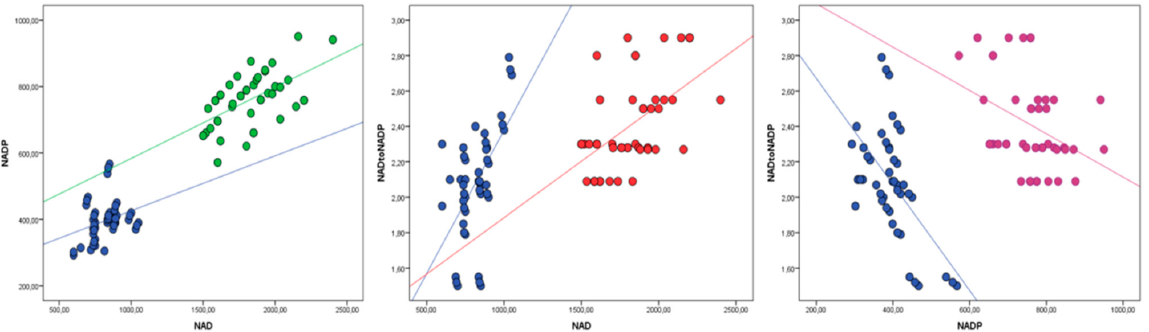
Figure 2. Linear regression curves between niacin status indicators NAD, NADP and NAD:NADP in cows that received (green, red, purple) and did not receive niacin (blue).